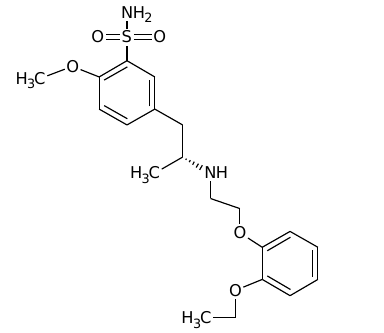
Figure 1. Chemical structure of tamsulosin. Figure 2. Chemical structure of